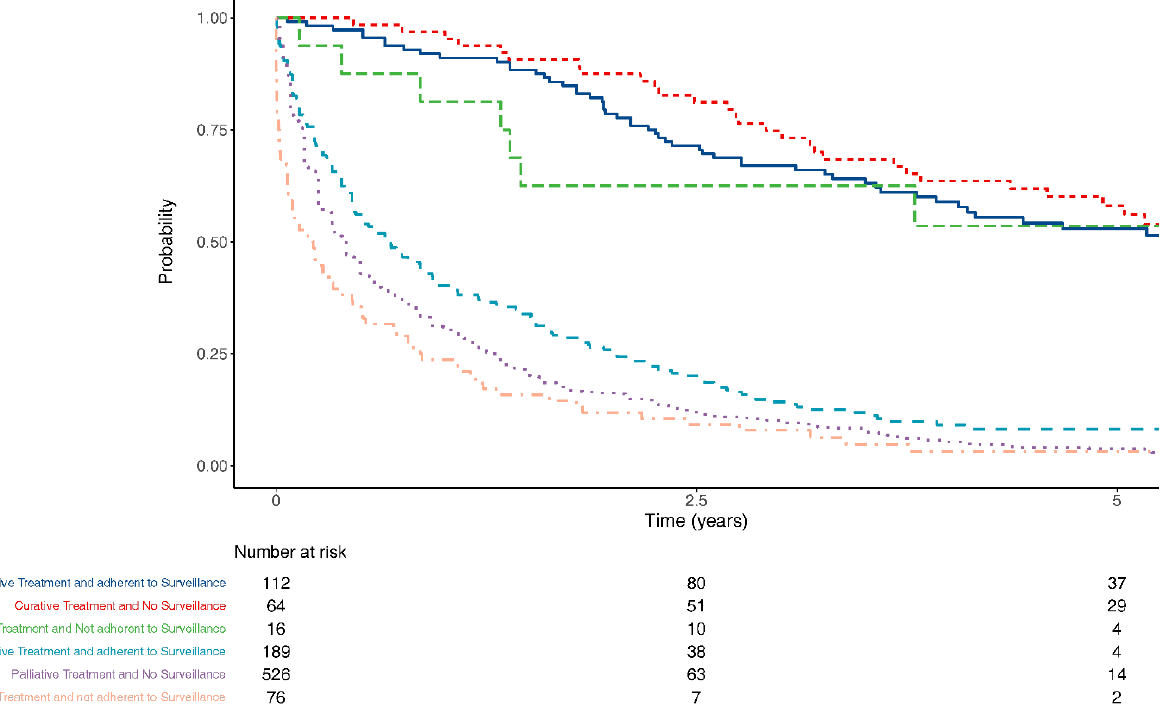
Figure 3. Overall survival by surveillance group and treatment intent, 270 days lead-time bias accounted for.